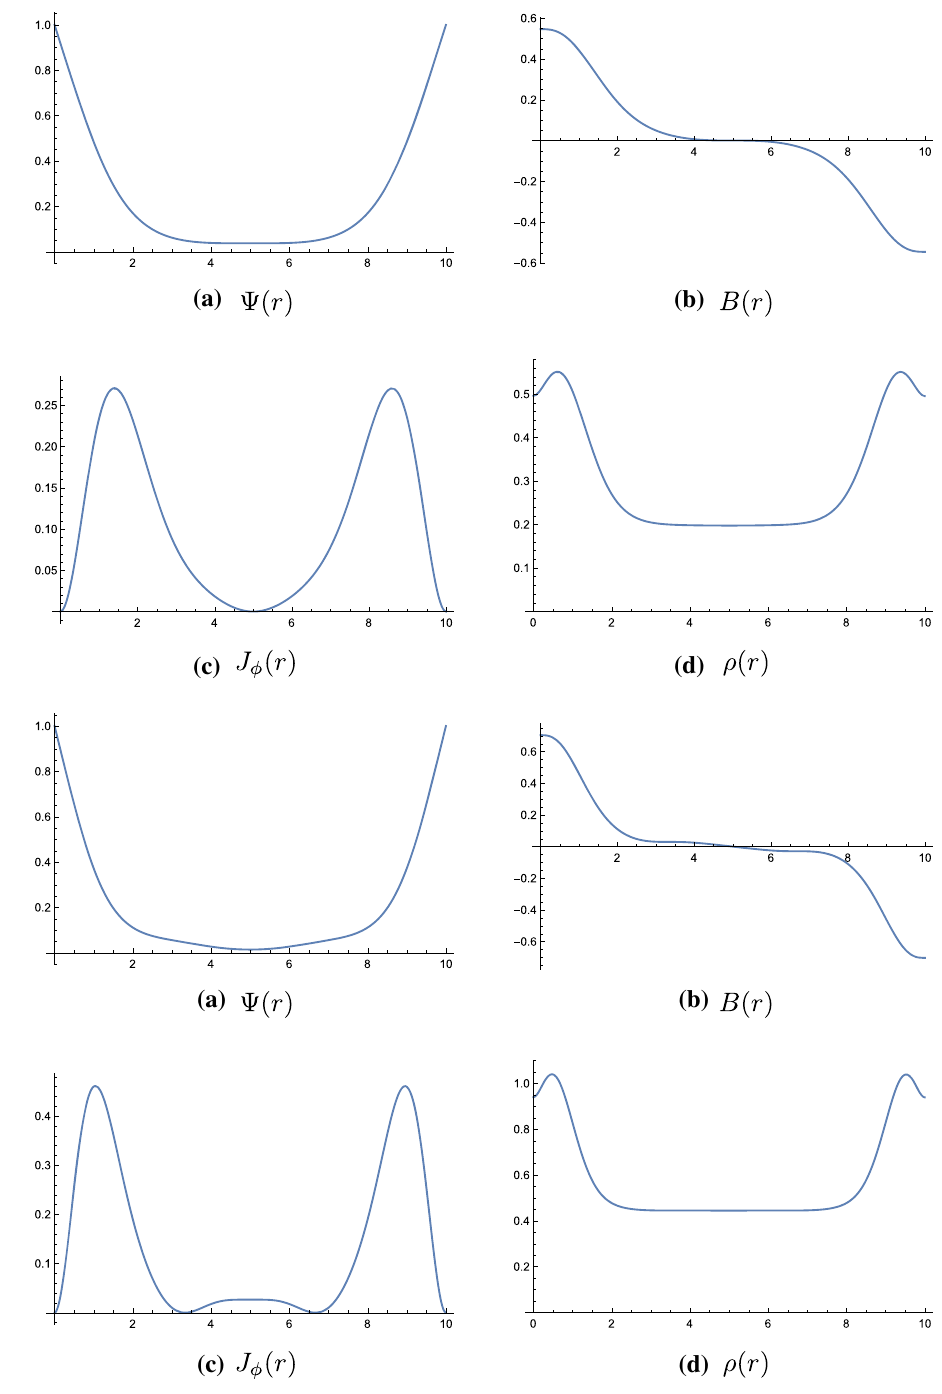
Fig. 10 Profiles for the gauged baryon-antibaryon solution m = 1 with periodic boundaries for (cid:16) . The profile function F ( r ) is defined by E 0 = 2 π 2 / R 2